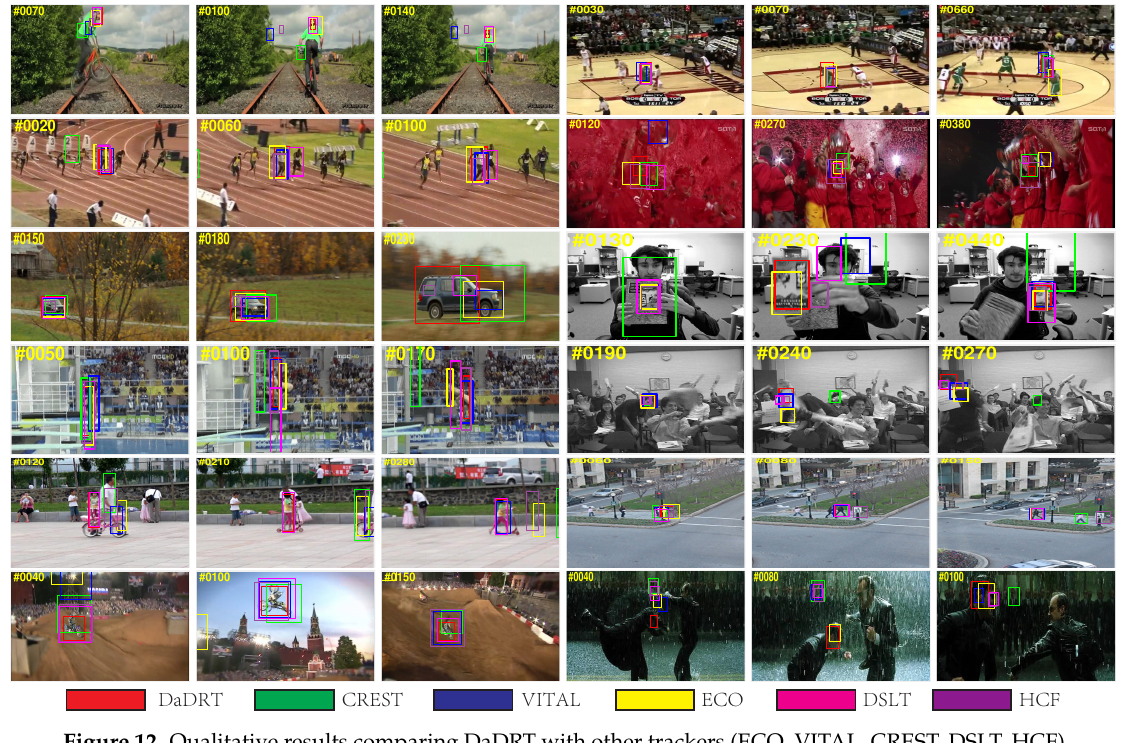
Figure 12. Qualitative results comparing DaDRT with other trackers (ECO, VITAL, CREST, DSLT, HCF) on 12 challenging sequences (from left to right and top to down: bike , basketball , bolt2 , soccer , carscale , clifbar , diving , freeman4 , girl2 , human3 , motorrolling and matrix , respectively). The proposed DaDRT tracker performed favorably against state-of-the-art methods. In the very challenging soccer , clifbar , and motorrolling sequences, DaDRT can always track to the target when most other trackers fail. Results are best viewed on high-resolution displays.